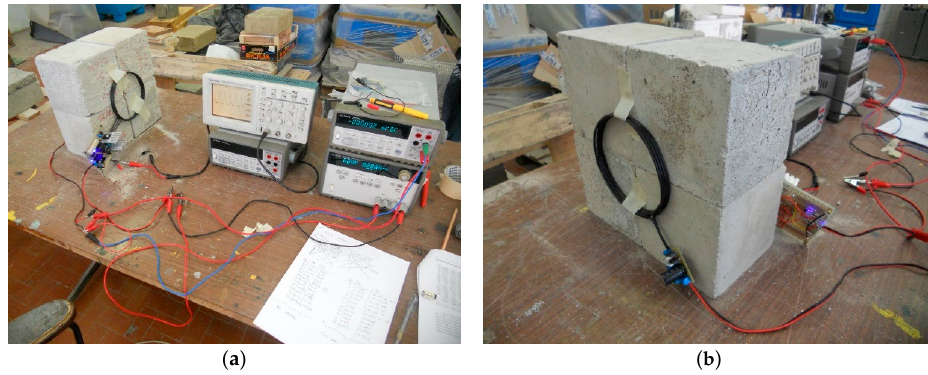
Figure 13. Inductive charging system test setup, concrete environment: ( a ) is the test bench set-up, including the required instrumentation; and ( b ) is a picture of the set-up of the coils.